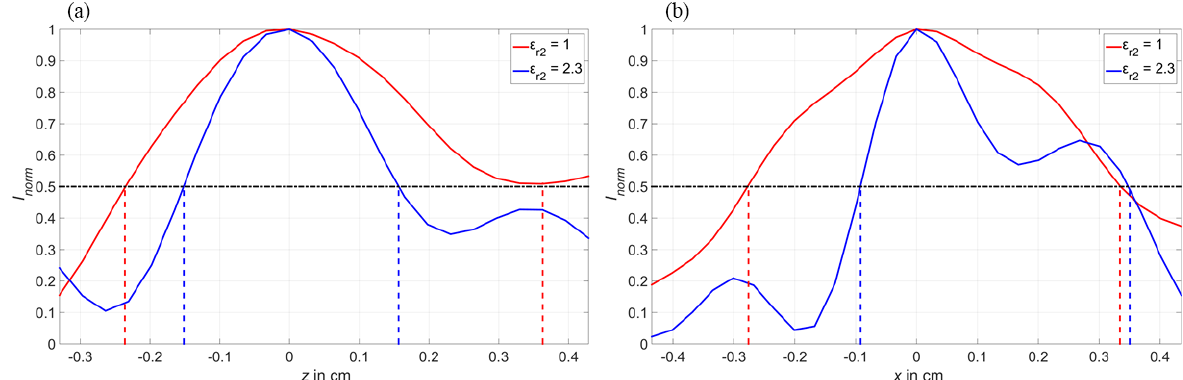
Figure 9. Comparing the resolution of free-space reconstruction ( ε r 2 = 1) and material-sensitive reconstruction ( ε r 2 = 2.3) on the upper target. (a) Range resolution; (b) lateral